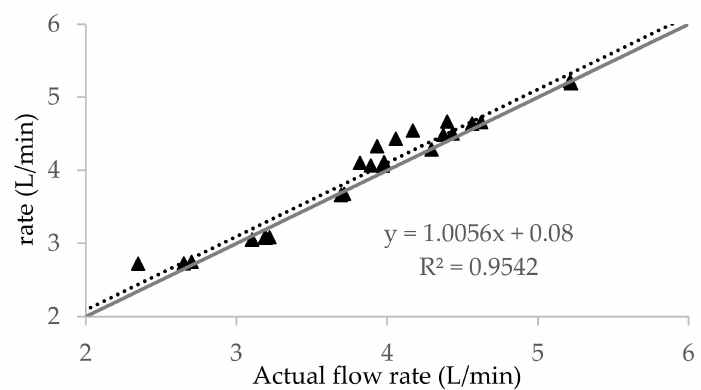
Figure 11. Controller-estimated flow rate using the flow meter vs. the actual flow rates measured by hand. The black triangles represent the recorded flow meter values while the grey line represents a 1:1